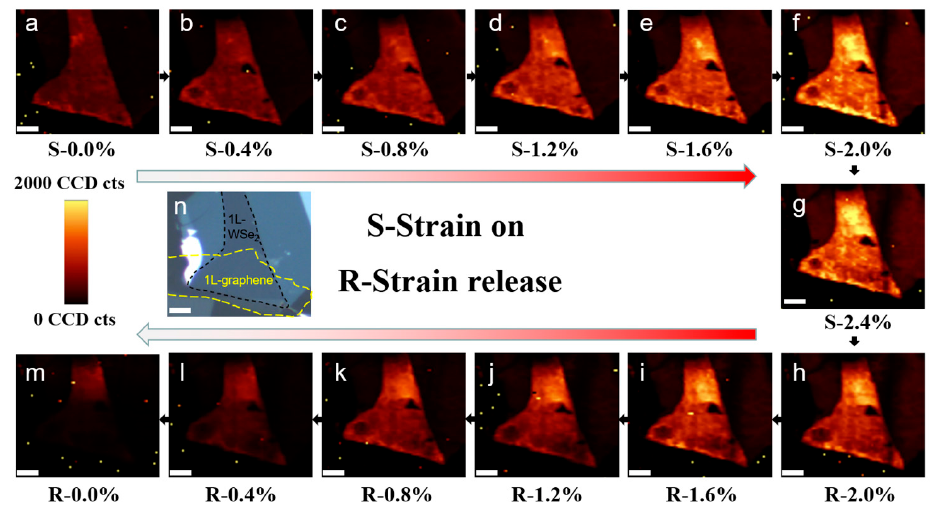
Figure 3. ( a – g ) corresponds to PL emission intensity of monolayer WSe 2 and graphene/WSe 2 heterostructure for the strain on the process from 0% to 2.4%, ( g – m ) corresponds to PL emission intensity of monolayer WSe 2 and graphene/WSe 2 heterostructure for strain release process from 2.4% to 0%. ( n ) is the optical view showing the boundary of the sample; the black area is the bottom layer 1L-WSe 2 , and the yellow area is the top layer 1L-graphene. The scale bar is 4 µ m in all figures. To further confirm our conclusion, we applied pre-strain treatment to all the samples shown in Figure 4. For each sample in Figure 4, we first applied strain up to 1.6%, then released it to 0% and re-do the strain modulation again. Figure 4a shows the change of fitted PL emission energies (A and A T ) of 1L-WSe 2 during the first (pre-strain) and second strain on process. It shows that the A and at the peak of 1L-WSe 2 during the second strain on the process are much smoother, and the fitting curves are more linear, which can be attributed to the same reasons as monolayer WSe 2 in Figure 1a. Figure 4b is the change of fitted PL emission energies A and A T ) for 1L-WS 2 during the first (pre-strain) and second strain modulation process, in which the fluctuations during the pre-strain process show poor interface contacts and/or large residue strain between WS 2 and PET substrate and thus improved during the second strain on process. Figure 4c,d shows the strain modulation for the heterostructures of WSe 2 /WS 2 and MoSe 2 /WS 2 with pre-strain treatment. Figure